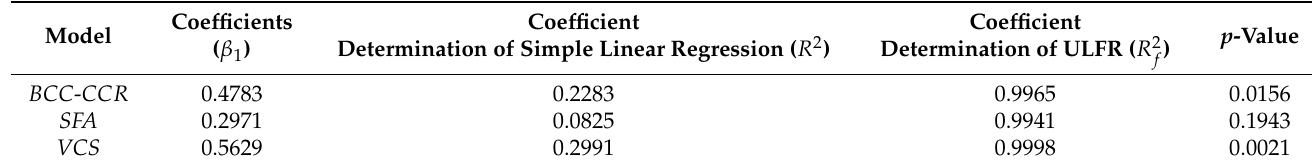
Table 5. Statistical assessment of the BCC - CCR , SFA , and VCS